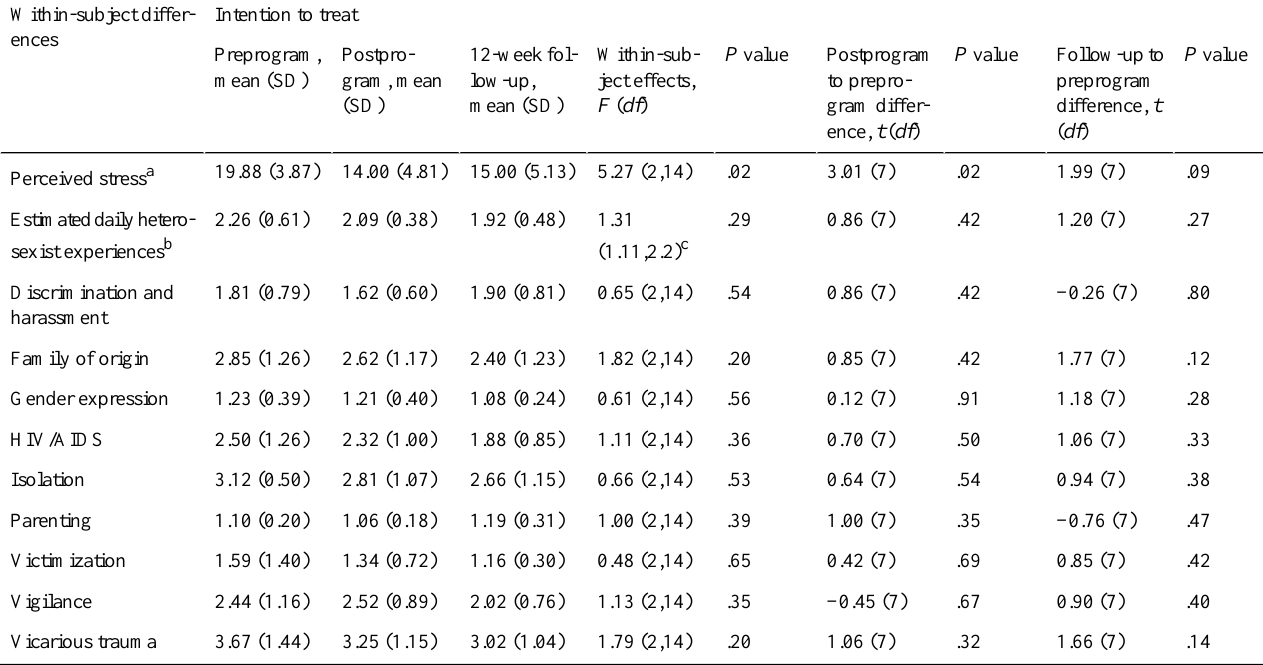
Table 6. Within-subject differences in perceived and minority stress in gay and bisexual men participating in online mindfulness-based stress reduction, by intention-to-treat